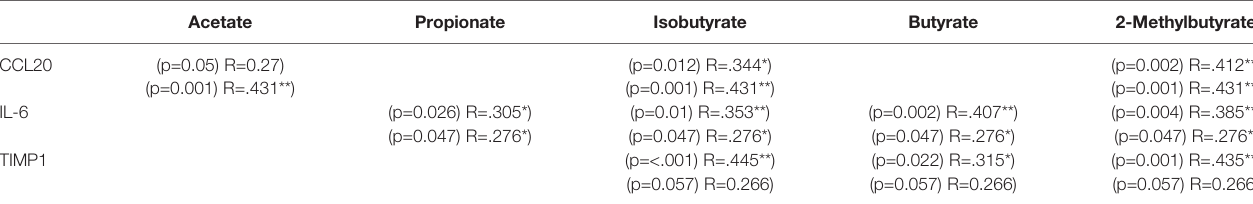
TABLE 6 | Intracranial proteins correlated with both SCFAs and NIHSS admission